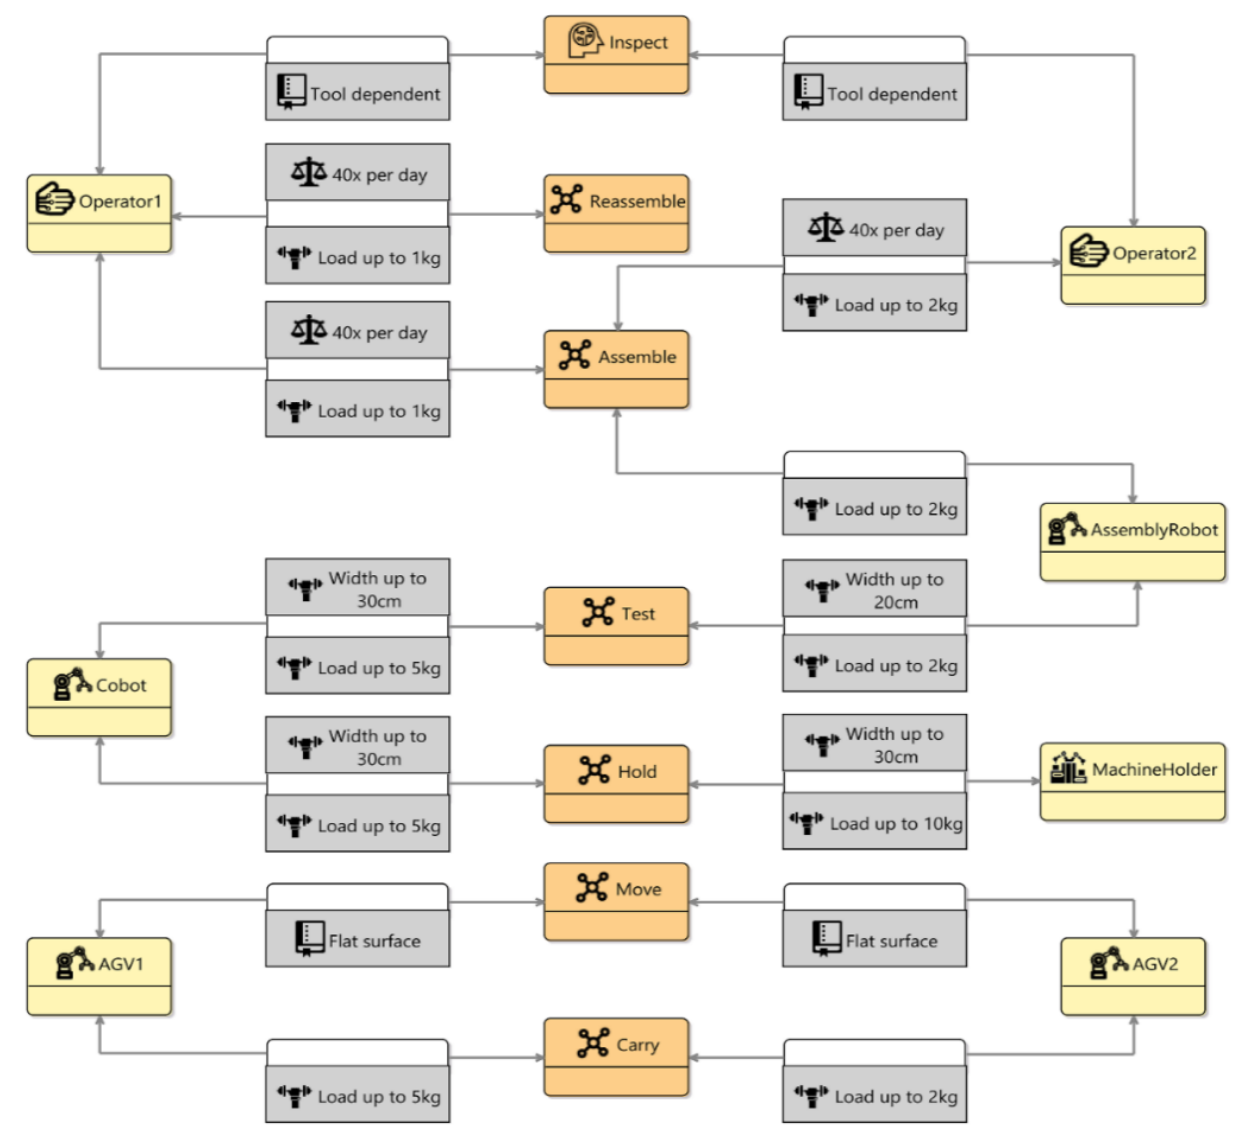
Figure 5. The default layer of the resource model, created in Resource Modeller.